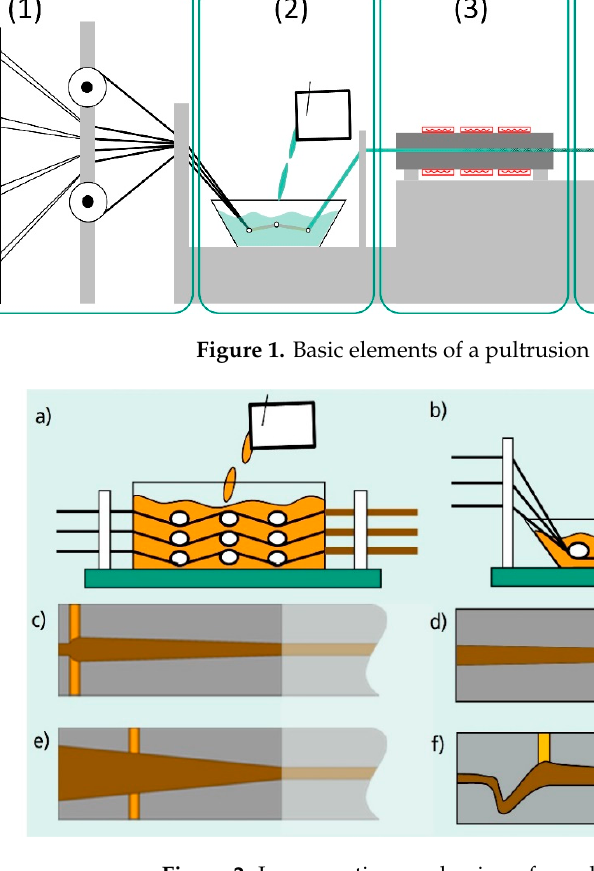
Figure 2. Impregnation mechanisms for pultrusion.